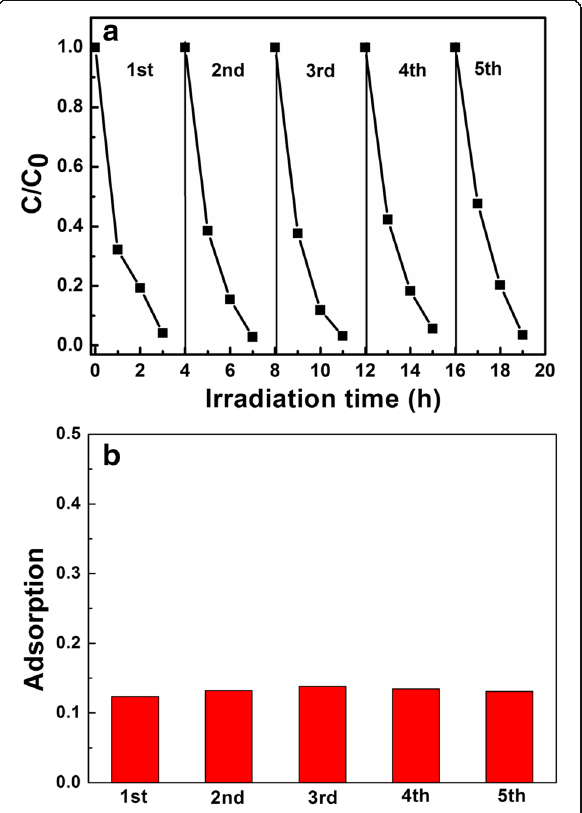
Fig. 7 Cycling a photo-degradation and b adsorption of MB over LNO700 powder